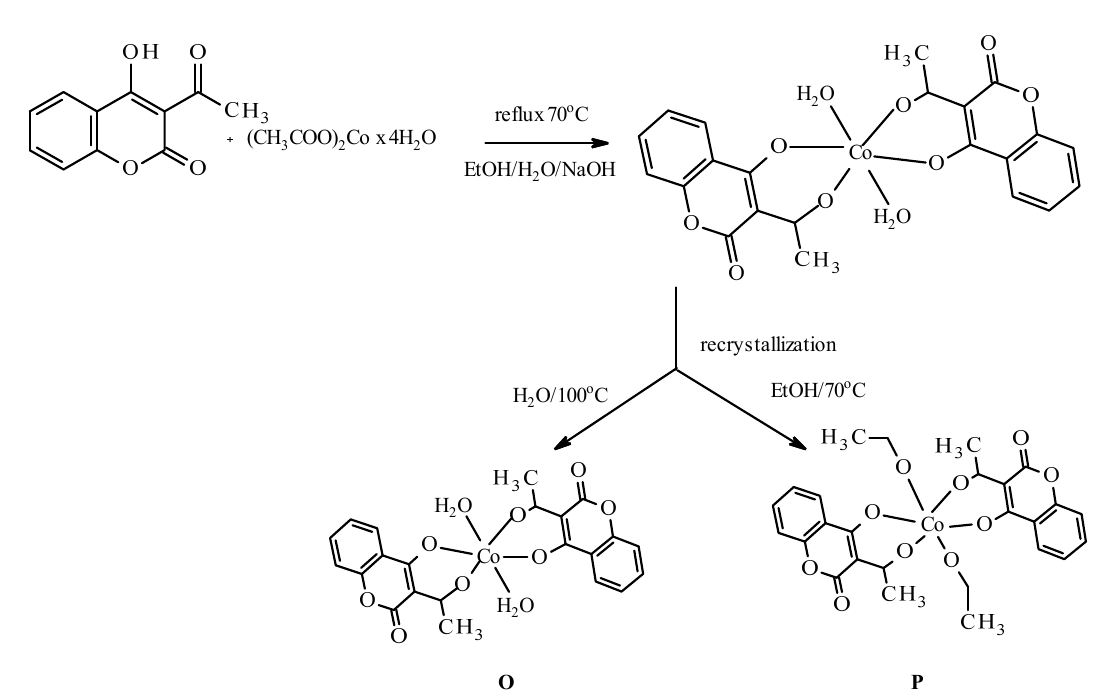
B Figure 8. General structure of flavonoids with indicated sites of binding with metal ions. Complexes of Cu(II), Fe(II), Fe(III), Ni(II), Zn(II) with rutin ( 26 ) are better anti-inflam- matory agents [255,256] and a complex of Mg(II) with rutin ( 26 ) is active against rat paw edema induced by serotonin. Fe(III) complex of rutin ( 26 ) suppresses lung edema [242], but it stimulated release of oxygen radicals from macrophages. Other studies indicated that complexes of Cr(III) [257], Cu(II) [258], Fe(II), Zn(II) [239], VO(IV) are better radical scavengers than ligands. 6.2. Complexes of Coumarins with Metal Ions The antioxidant activity is related to prevention of development of neoplasms caused